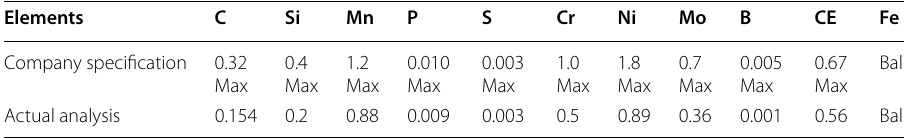
Table 7 Chemical compositions of the Armox 500T steel plate, wt. %